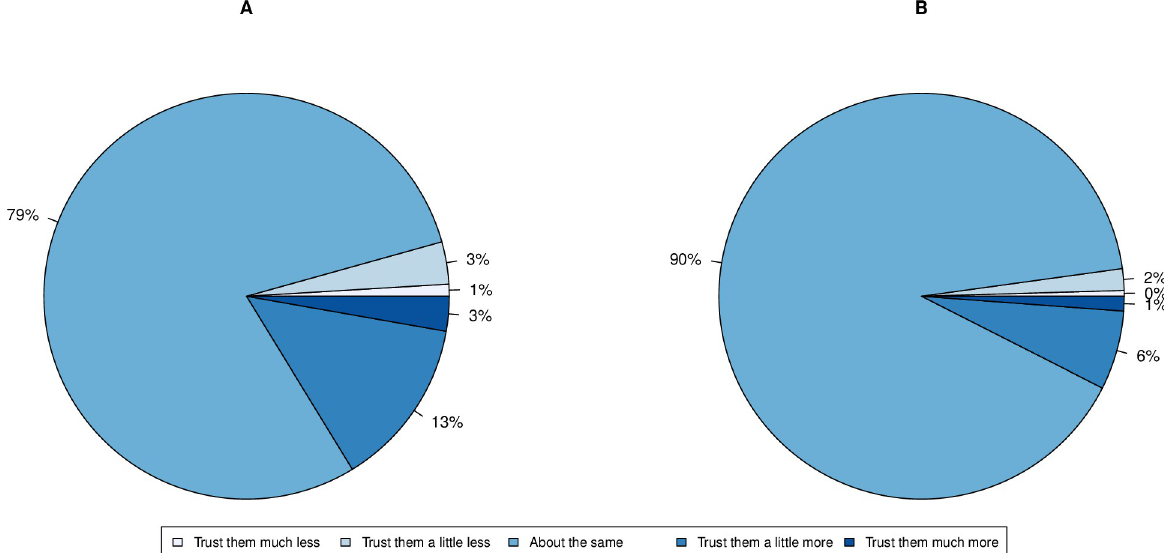
Fig 2. Proportion of individuals in each class of self-reported change in trust in A. “geneticists” (N = 1987) and B. “geologists” (N = 1969) during the COVID-19 pandemic. Figures are rounded such that < 0.5% is rounded to 0%.